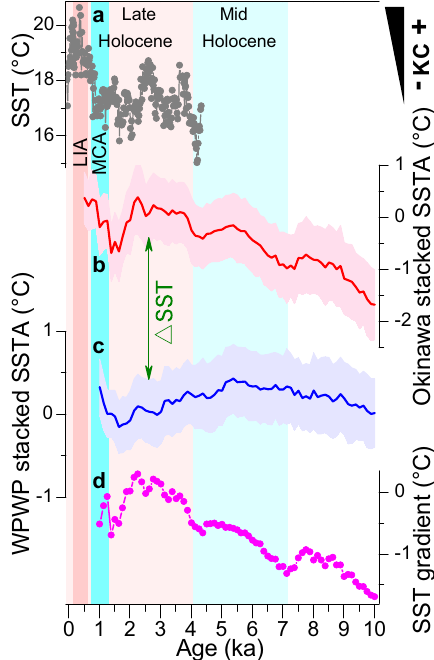
Fig. 3 Collection of published sea surface temperature (SST) records and ) SST opal contents in the northeast Paci fi c margins. Alkenone (U K 0 37 records (dots) and opal contents (cycles) for sediment cores at ( a ) site 11 47 , ( b ) site 12 48 , ( c ) site 13 39 , ( d ) site 14 40 and ( e ) site 15 41 (note the hiatus of the SST estimate at ~3 – 5 ka). Blue bar represents the weakening of the Alaska Current ( a , b ) and California Current ( c , d , e ) before ~4 ka, and red bar outlines their strengthening after 3 – 4 ka, within which the Medieval Climate Anomaly (MCA) and Little Ice Age (LIA) are indicated as in Fig. 2. Dashed lines denote long-term (two intervals of 0 – 3 ka and 4 – 7 ka, respectively) averaged SST values of each record, and triangles indicate revised 14 C ages 20, 21 correspondingly (note that two sites 12 and 14, as controlled by fewer 14 C dates, with a larger uncertainty in the age model, are still enough to outline multimillennial-scale SST patterns due to high sedimentation rates, Source